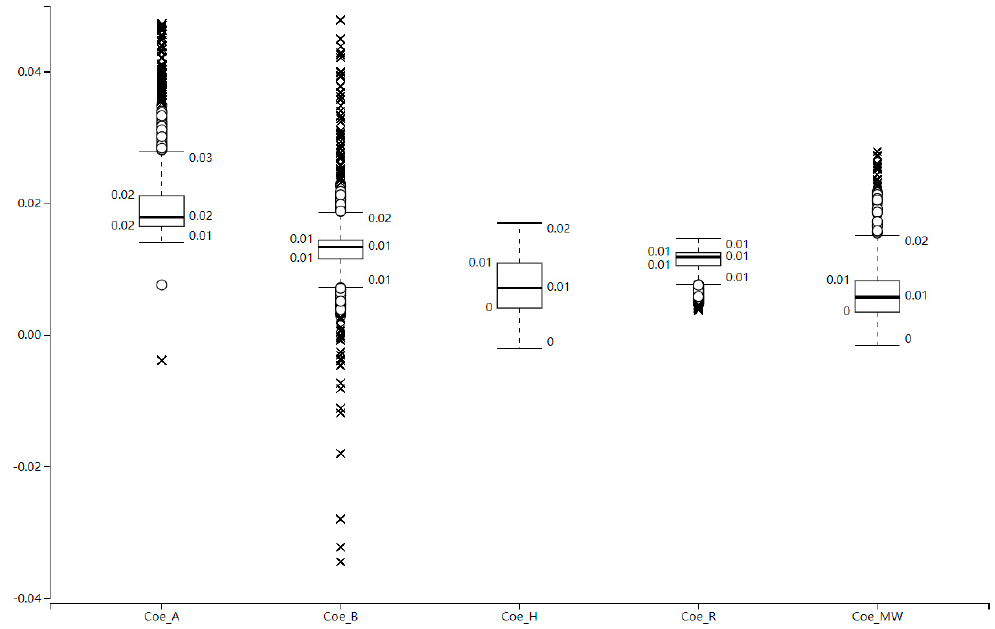
Figure 8. Box diagram of variable coefficients.